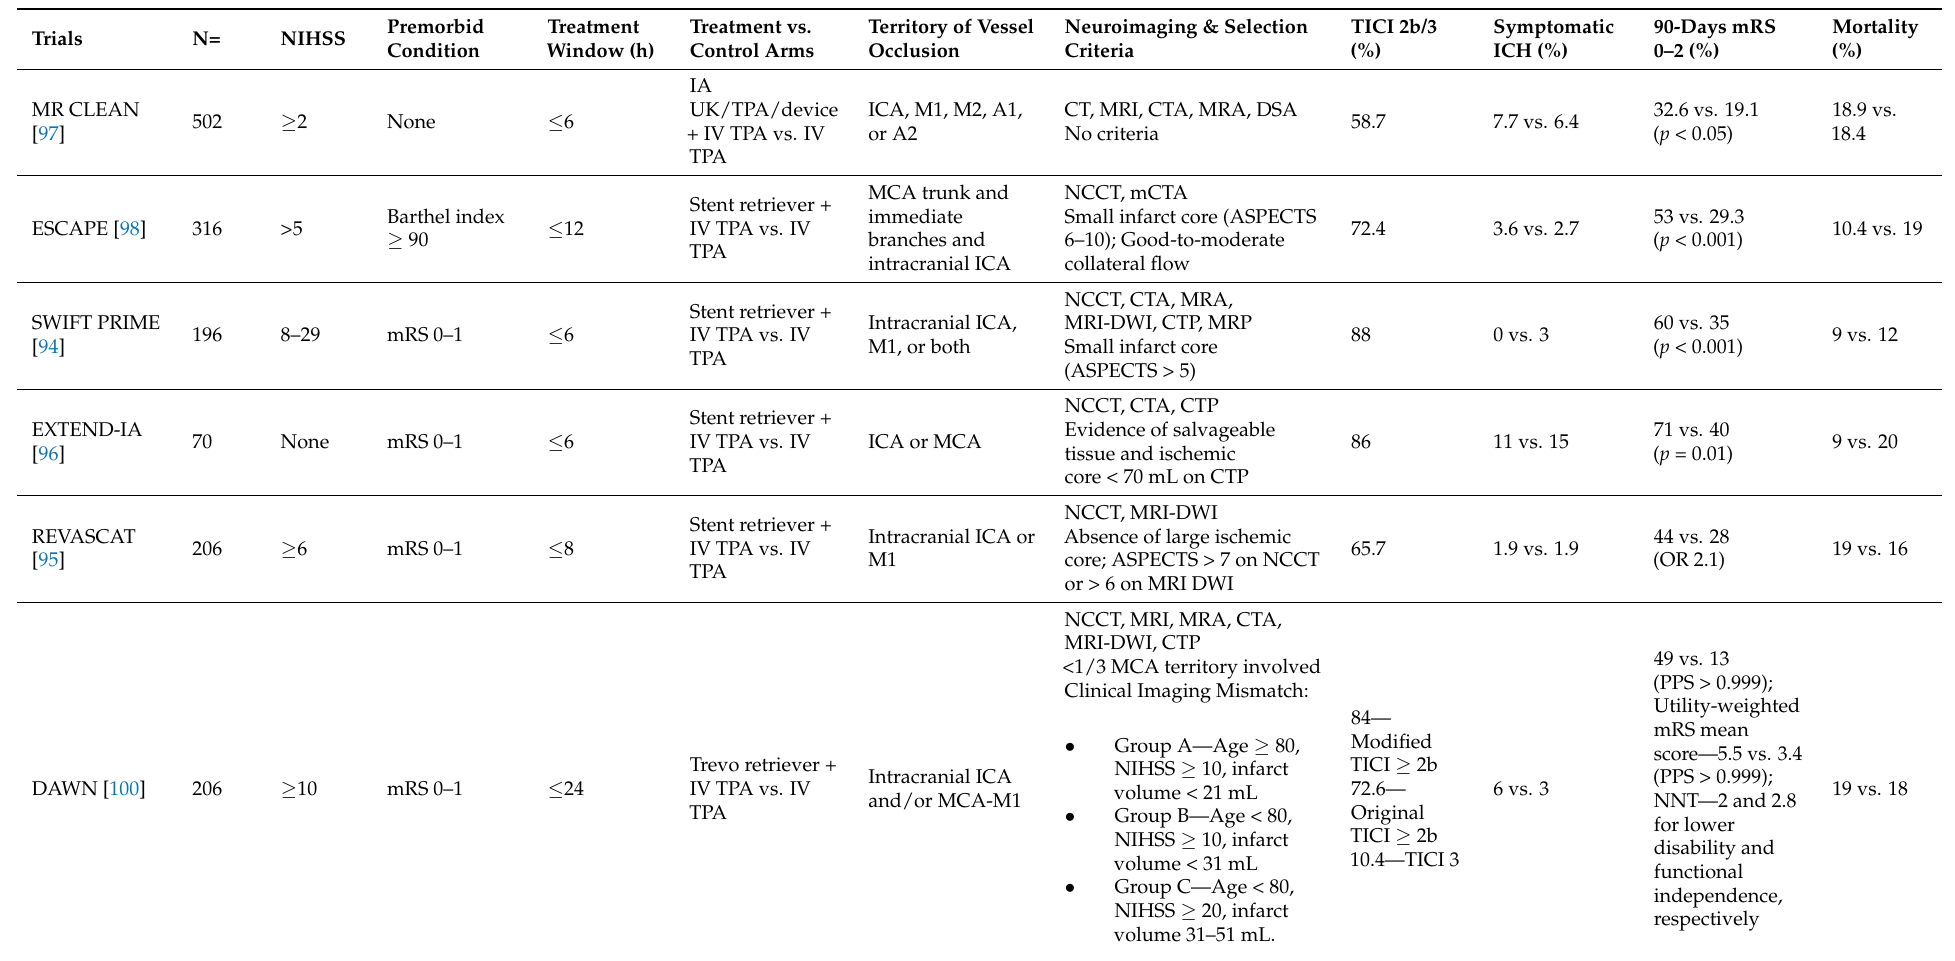
Table 4. Landmark Trials of Endovascular Thrombectomy in Acute Ischemic